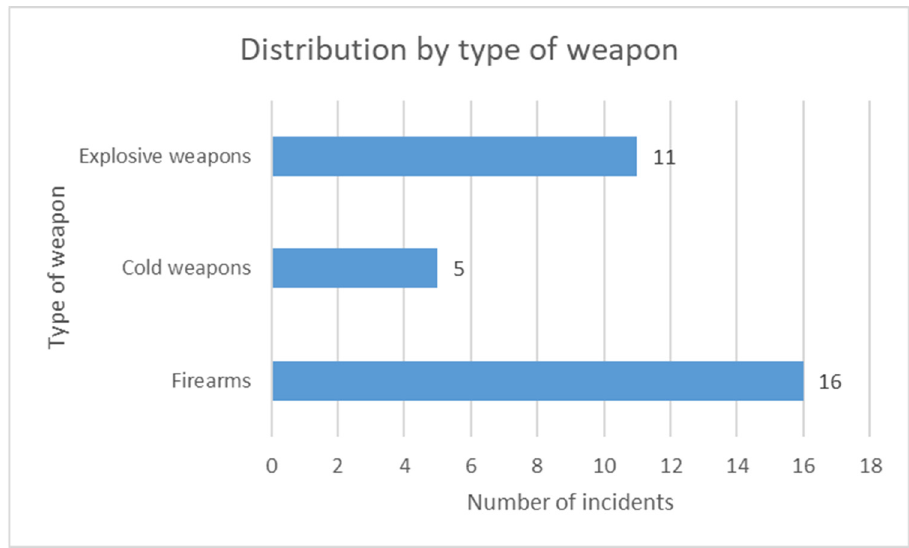
Figure 3. Distributions by type of weapon (N = 21 cases). Cold weapons are non-fire arms (knifes, blades, etc.) 7